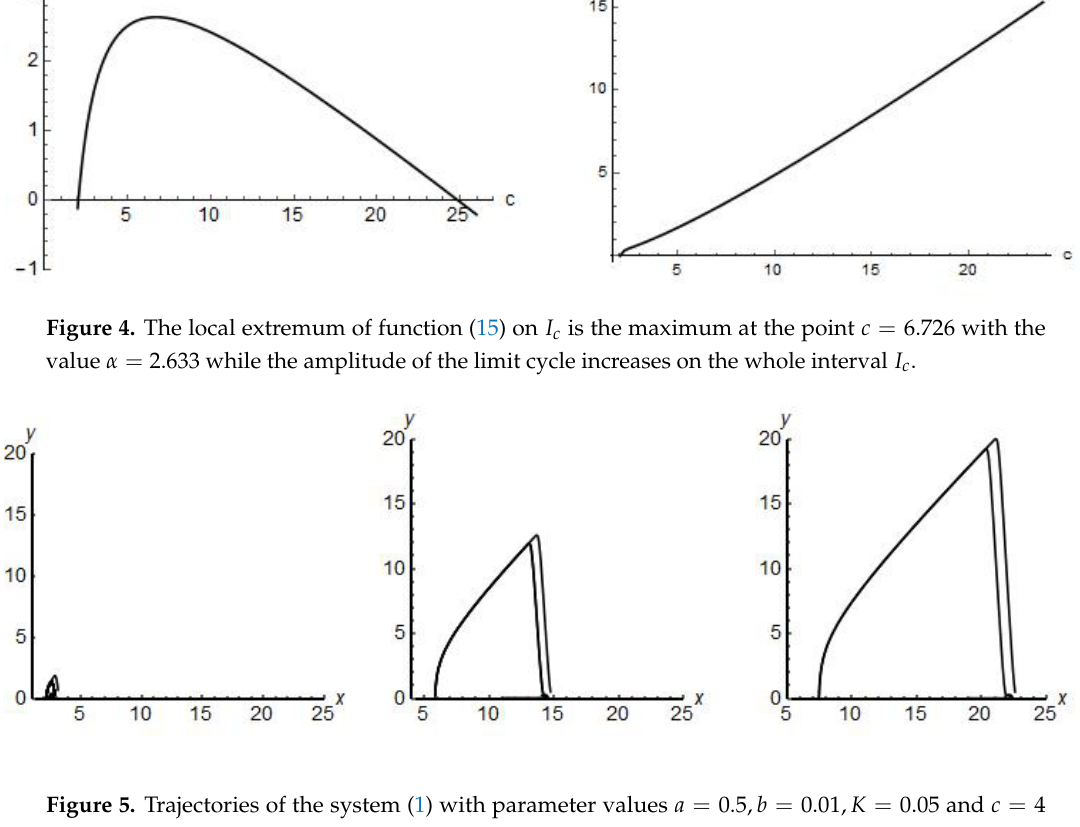
Figure 5. Trajectories of the system (1) with parameter values a = 0.5, b = 0.01, K = 0.05 and c = 4 (on the left ), c = 8 (in the middle ) and c = 16 (on the right ) coiling around the limit cycles with increasing